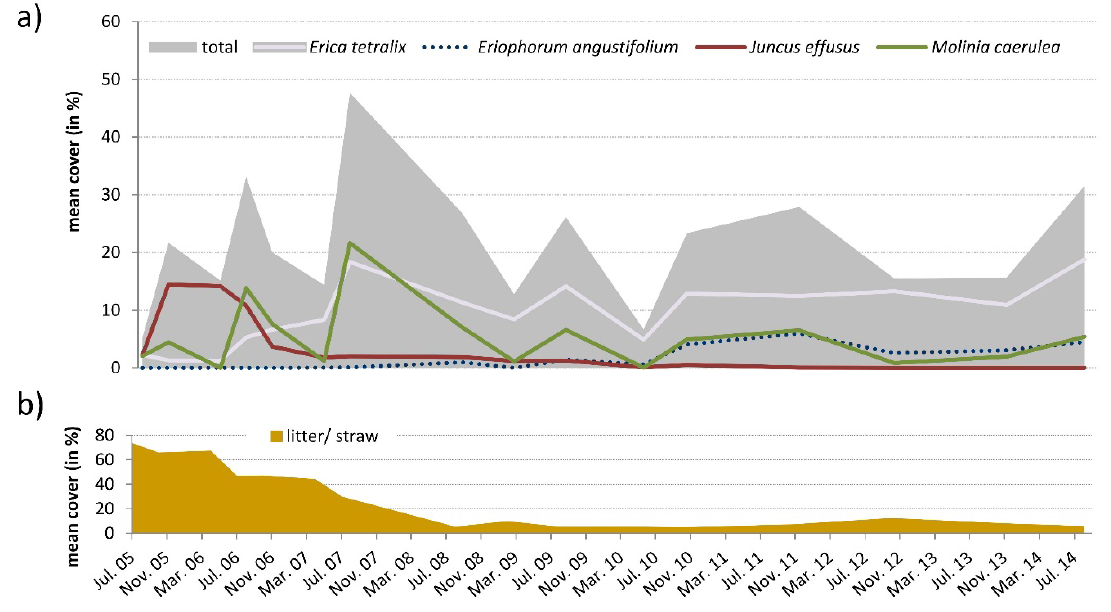
Figure 6. Development through time of a) mean total cover of vascular plants and selected species (%) and b) mean cover of litter including straw and mowed material, at the study